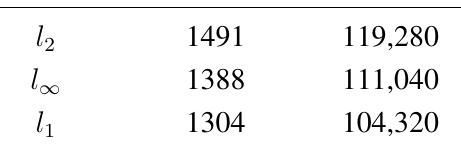
Table 5. number of mean computations, messages, and crossings per norm for feature “ipo” with threshold r = 0 . 0025 , and stream dependent local constraint δ